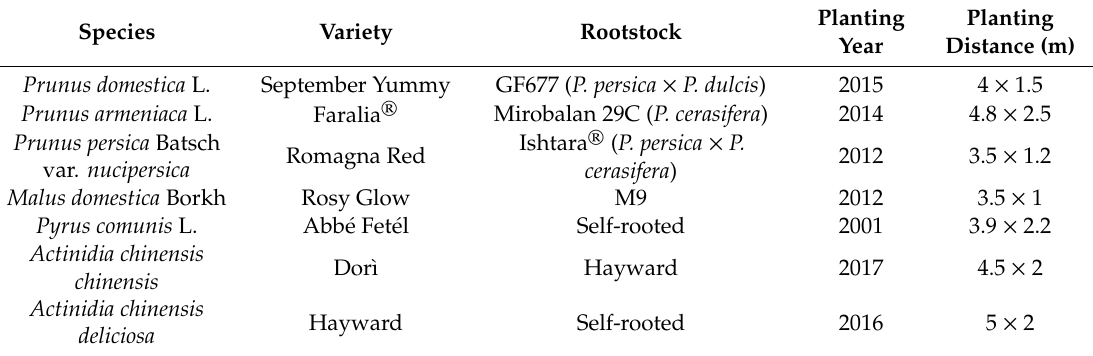
Table 1. Fruit species, variety, rootstock, year of plantation and planting density of the orchards. Species Variety Prunus domestica L.